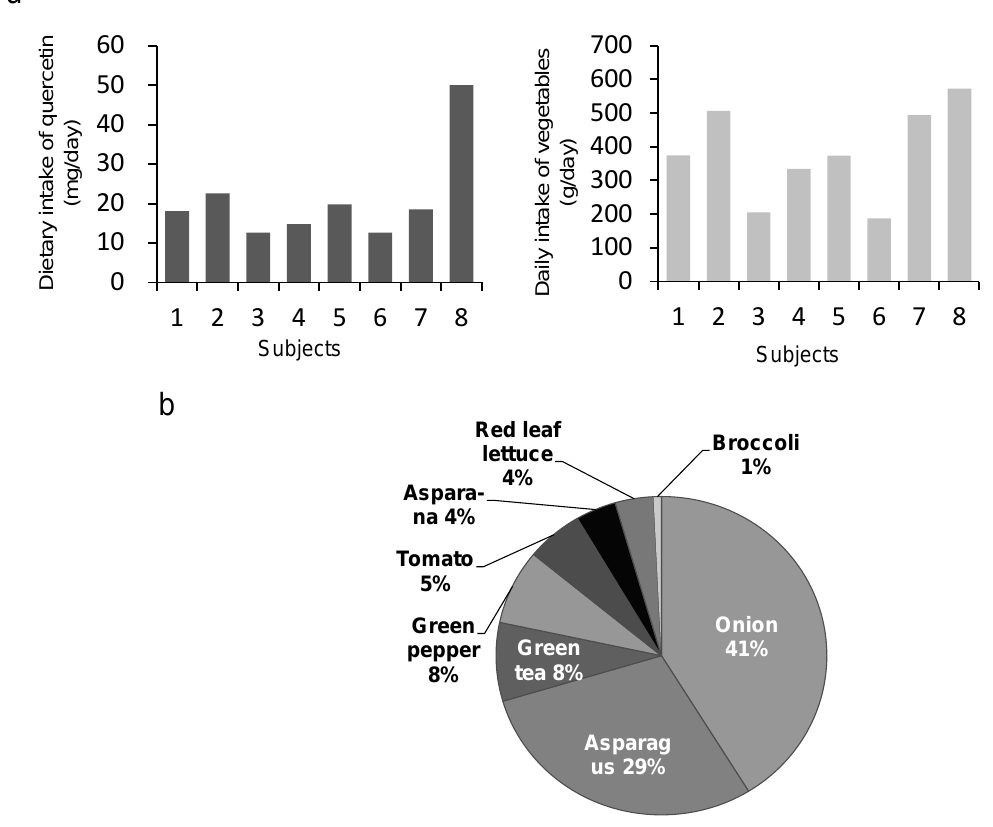
Figure 1. ( a ) Estimated intakes of quercetin and vegetables using two-day weighed food records of female volunteers. ( b ) Percentage contribution of foods to daily quercetin intake by the